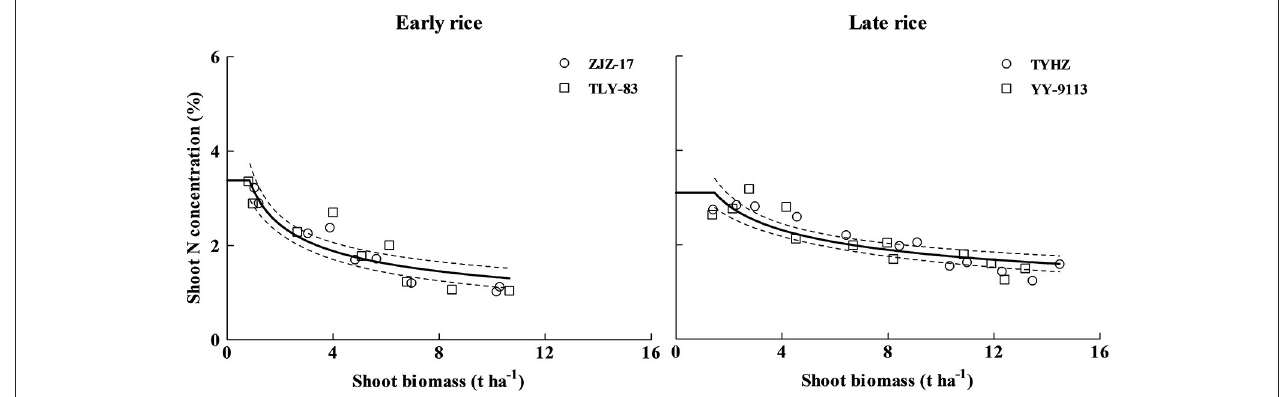
FIGURE 3 | Unified N c dilution curves of early rice (N c = 3.37 W − 0.44 R 2 = 0.8259) and late rice (N c = 3.69 W − 0.34 R 2 = 0.7834) in experiments conducted during 2013 and 2014. The solid line denotes the power function regression and the dotted lines represent the confidence bands ( p = 0.95). The solid lines parallel to x-axis represent the constant N concentration during early growth stage, the intersection between power function curve and linear line are (1.04 t ha − 1 , 3.31%DM) and (1.6 t ha − 1 , 3.15%DM) for early and late rice respectively.